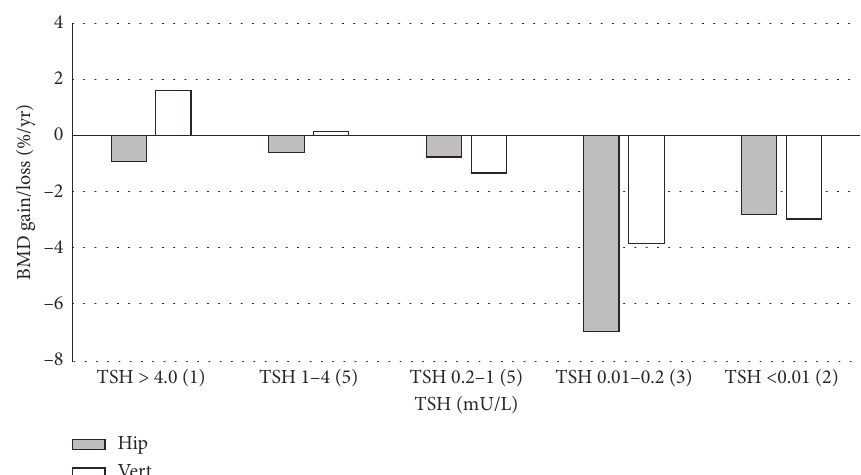
Figure 2: Categorical analysis of the variation in bone mineral density (BMD) loss/gain at the spine (vert) and hip in relation to TSH in a small subgroup of patients where serial BMD measurements were available. TSH values are in mU/L. Number of patients in parentheses.